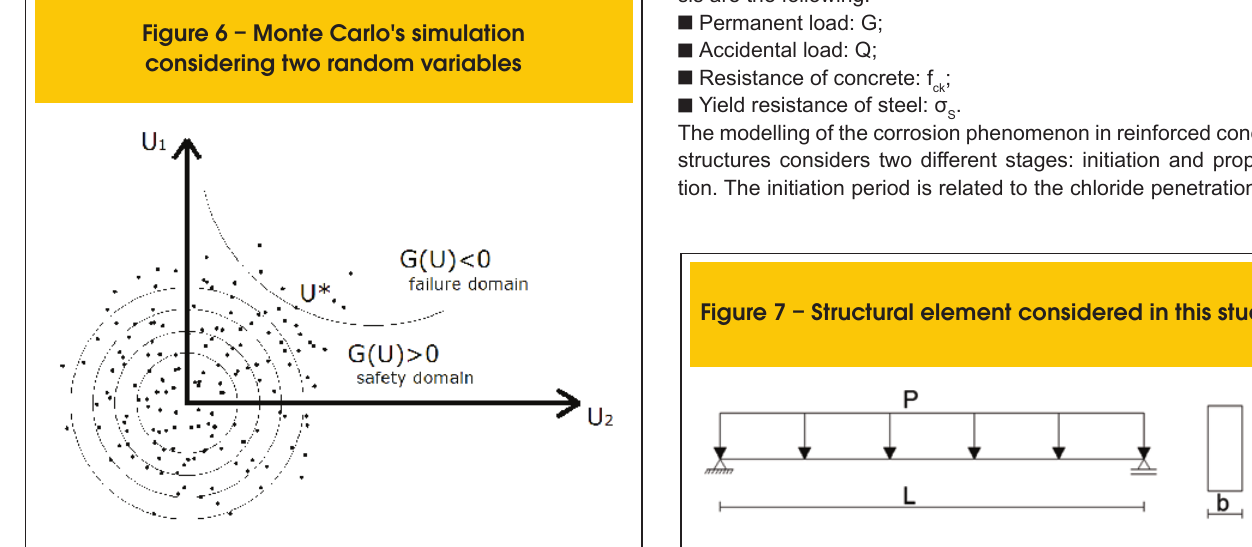
Figure 6 – Monte Carlo's simulation considering two random